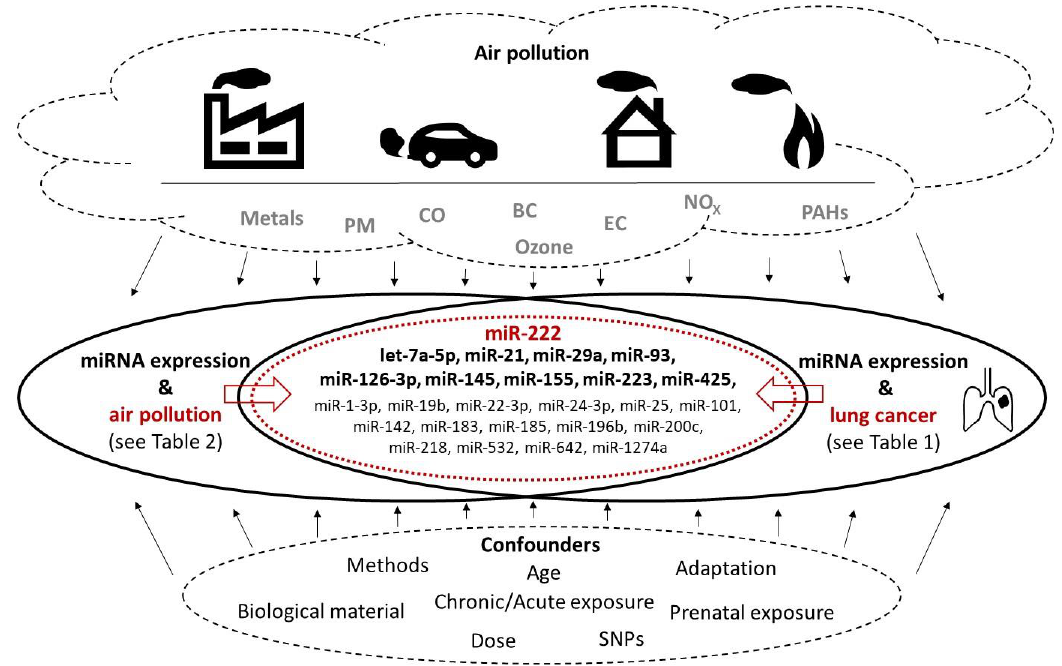
Figure 1. Graphical presentation of miRNAs commonly deregulated in lung cancer and human subjects exposed to various air pollutants. Factors affecting the results (types of air pollutants, methodological and other confounders) are also shown. See Table 3 for more details.